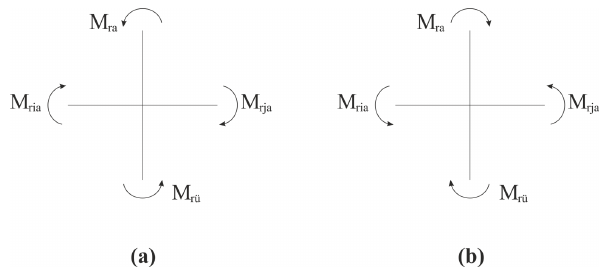
Figure 17. Bearing capacity moments affecting the node point (Er- soy U. and Ozcebe G., 2004).